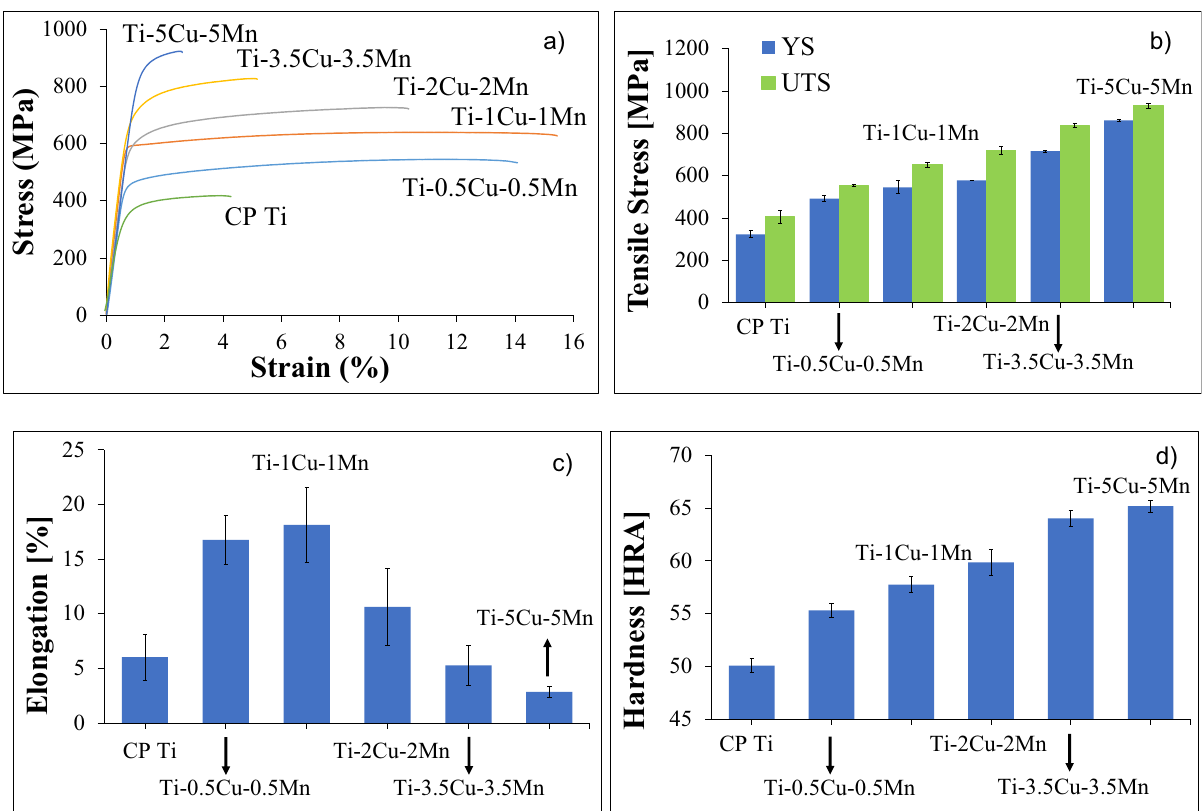
Figure 4. Mechanical behaviour of the β eutectoid bearing functionalised Ti alloys: ( a ) representative engineering stress–strain curves, ( b ) yield and ultimate tensile strength, ( c ) elongation at fracture, and ( d ) Rockwell hardness.